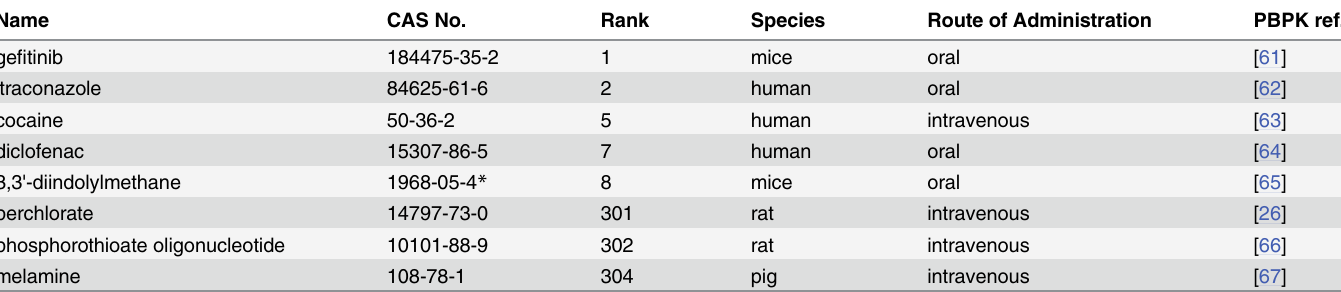
Table 3. Chemical names, CAS numbers, rank of correlation coefficient toward gefitinib, and related references of selected analogues of gefitinib. Name